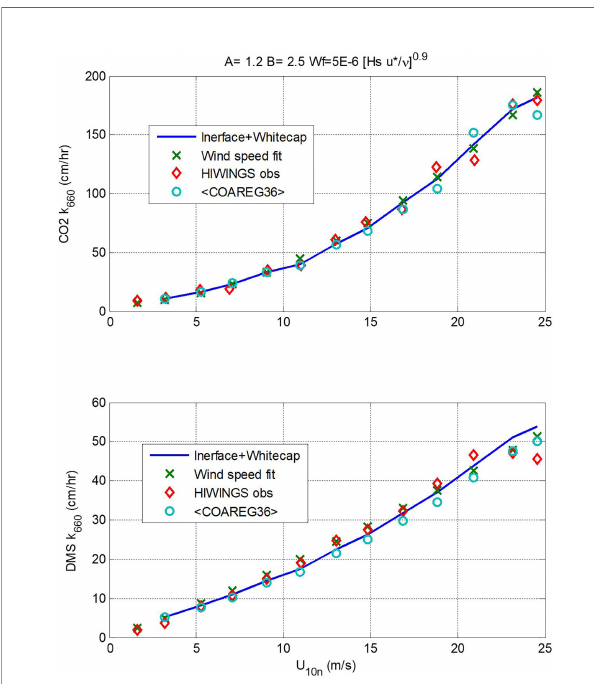
FIGURE 8 | Extraction of wind speed dependence of the turbo-molecular (upper panel) and bubble-mediated (lower panel) water-side transfer velocity terms using wind speed bin averages to the HiWinGS data. Two different whitecap formulations are used for the B term: f wh 2 is (49). and f whva is Deike et al. (2016). The solid lines are values extracted by applying the analysis to COAREG36